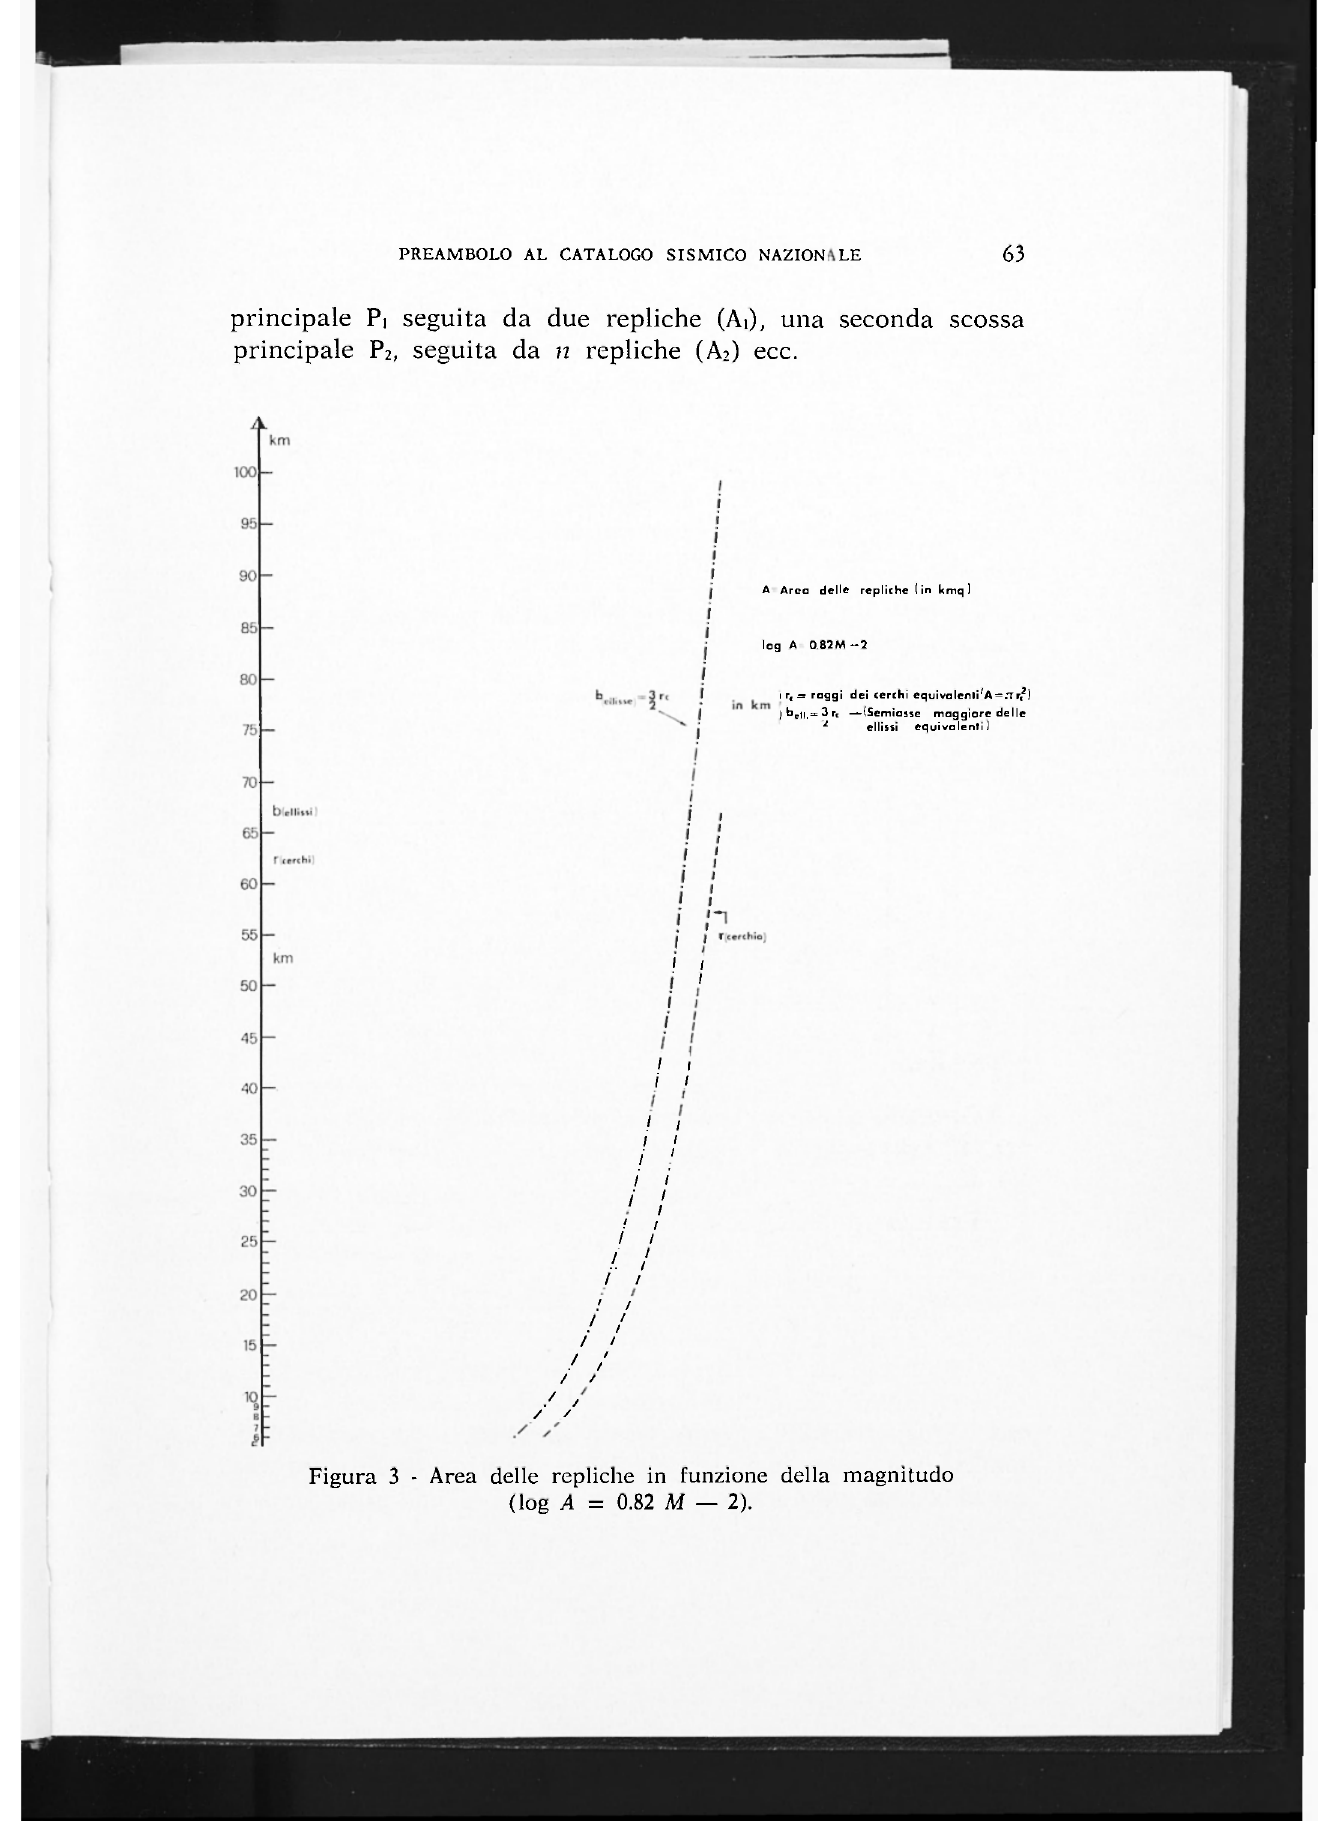
Figura 3 - Area delle repliche in funzione della magnitudo (log A = 0.82 M —